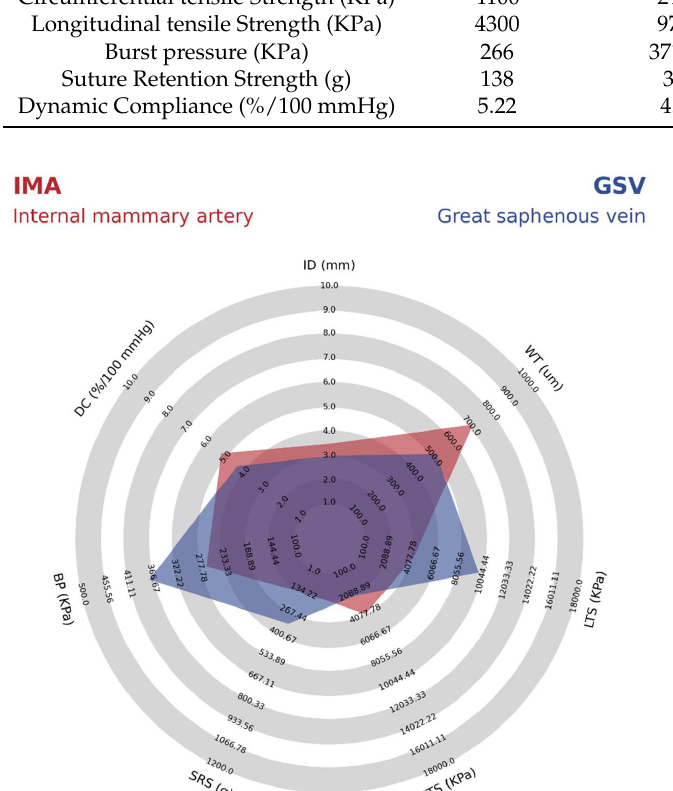
Figure 3. Comparison of the mechanical properties of the internal mammary artery (IMA) and great saphenous vein (GSV) as vascular grafts. Identified mechanical properties include internal diameter (ID), wall thickness (WT), longitudinal tensile strength (LTS), circumferential tensile strength (CTS), suture retention strength (SRS), burst pressure (BP), and dynamic compliance (DC). Chart